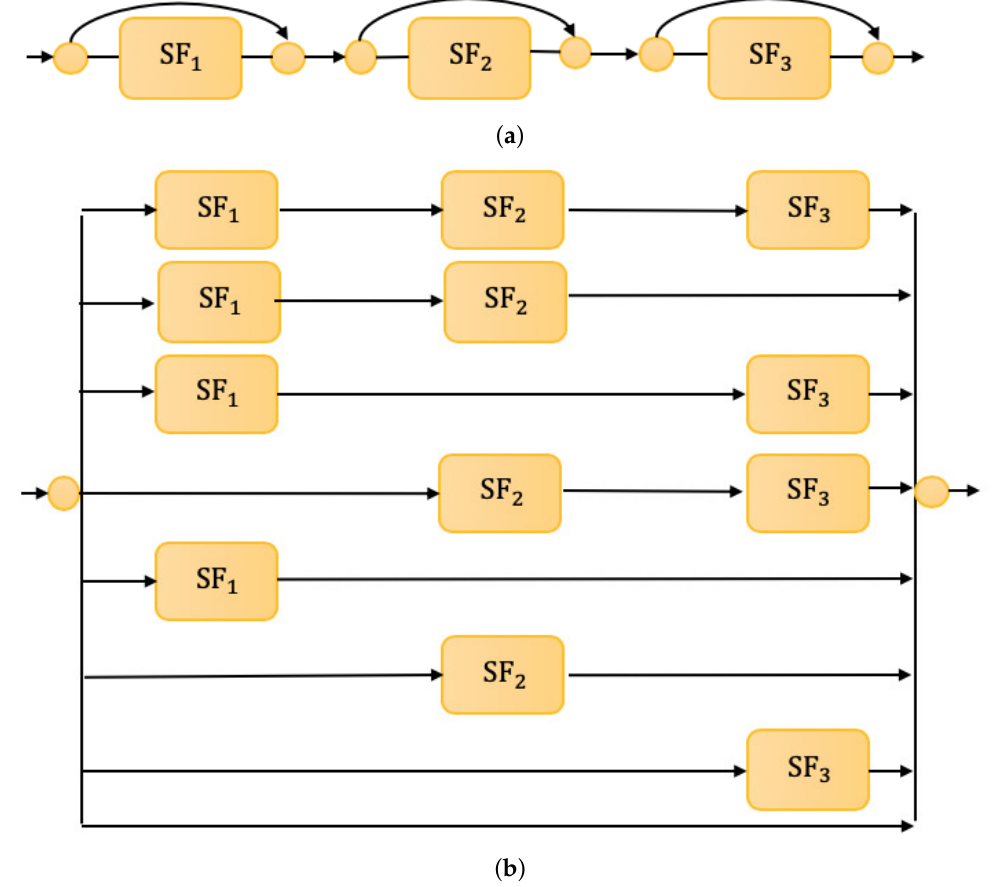
Figure 4. Multi-route sparse network architecture. ( a ) Short-connection network structure. ( b ) Equiv- alent multi-route network